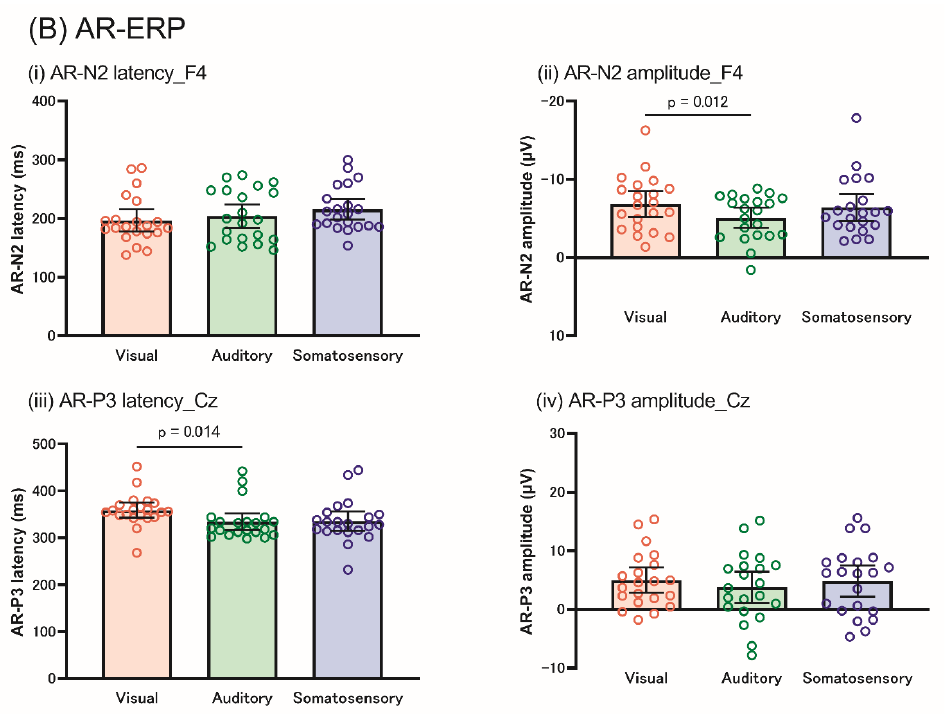
Figure 6. The differences in the AP-ERP ( A ) and AR-ERP ( B ) among each sensory modality. The orange, green, and blue blocks indicate the visual, auditory, and somatosensory modalities, respec- tively. ( A ) shows that AP-N2 latency was shorter in the visual modality than in the auditory and somatosensory modalities (i), while AP-N2 amplitude (ii), AP-P3 latency (iii), and amplitude (iv) were not significant. ( B ) AR-N2 amplitude was larger in the visual modality than in the auditory modality (ii). AR-N2 latency (i), AR-P3 latency (iii), and amplitude (iv) did not differ among the sensory modalities. The N2 and P3 components indicate the data from F4 and Cz, respectively. AP, action postponing; AR, action restraint; ERP, event-related